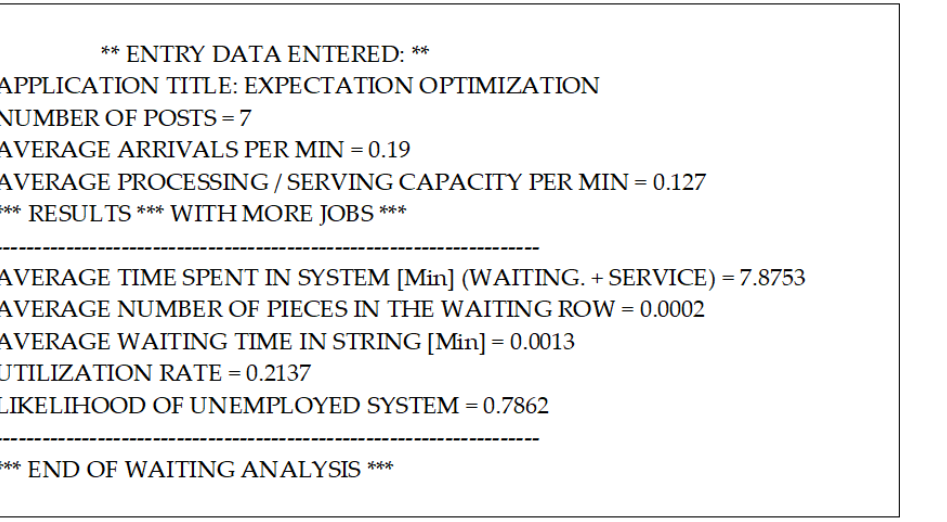
Figure 6. The results for the PP7 queueing system.